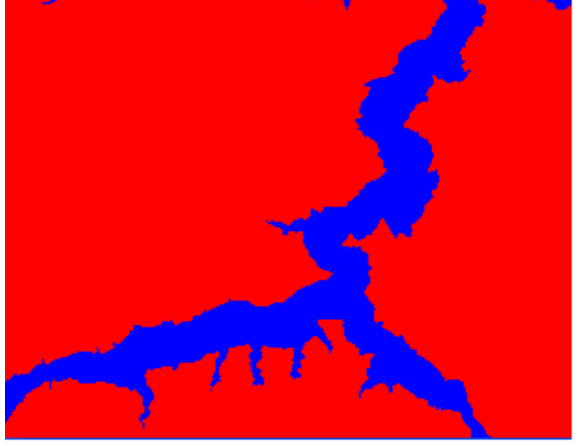
Figure 18. Forecast result of IsoData method.